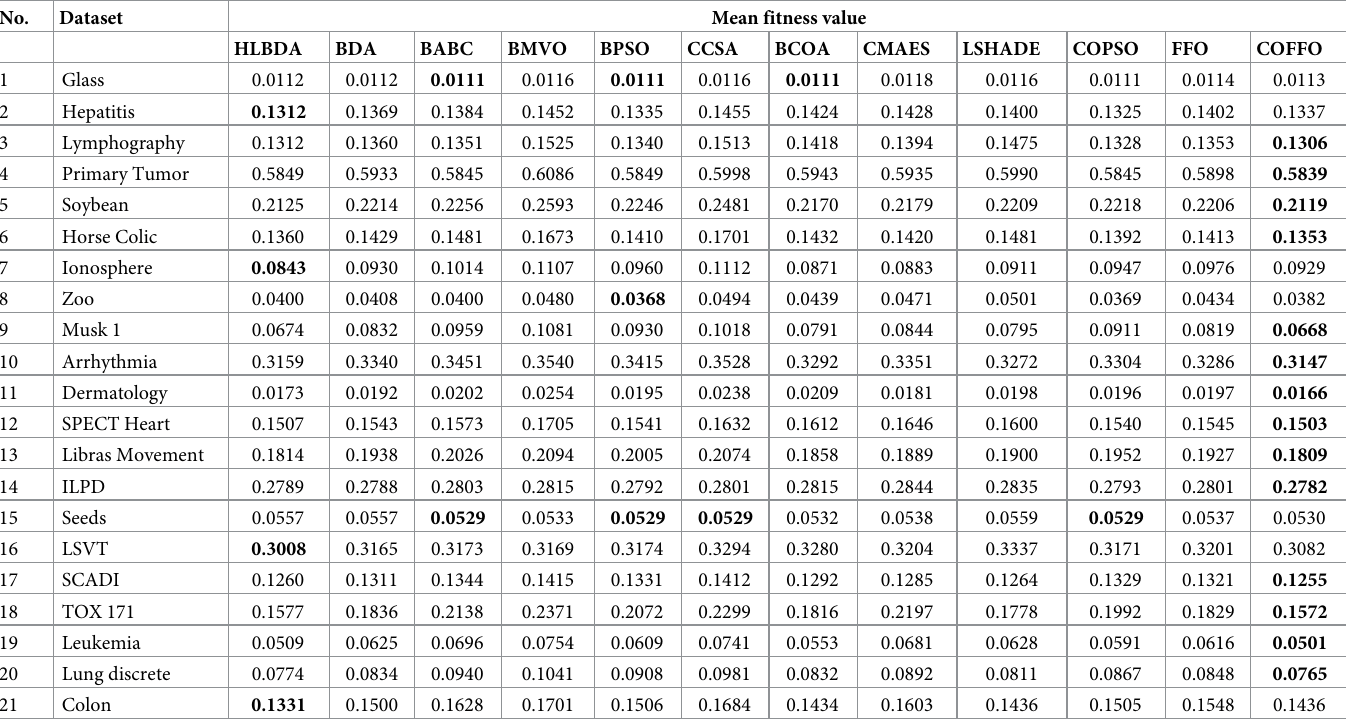
Table 10. Mean fitness value results for tested algorithms.